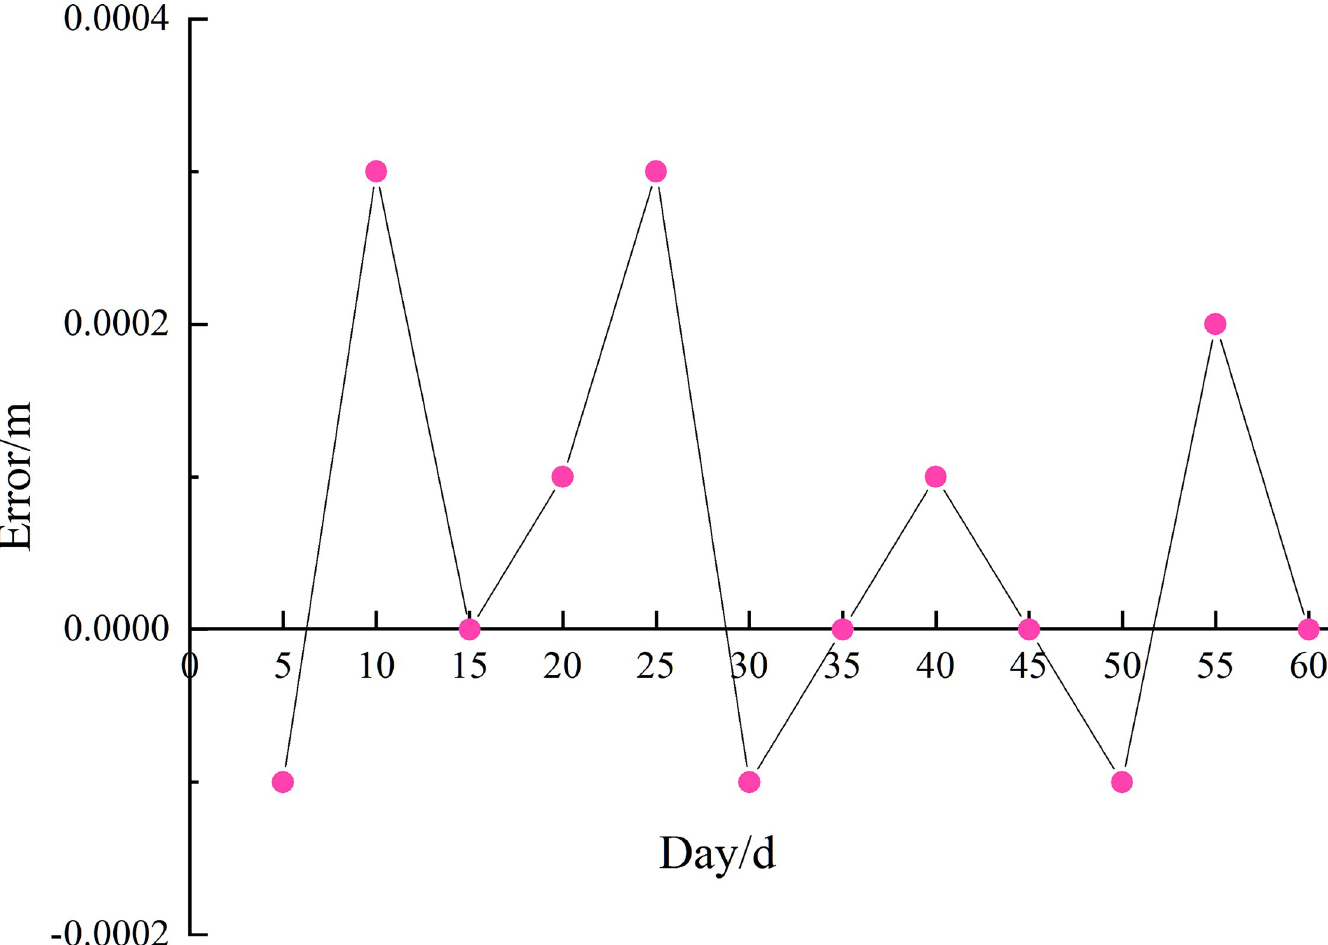
Fig 19. Positioning delay variation for a separation of positioning base stations of 70 m on different days.